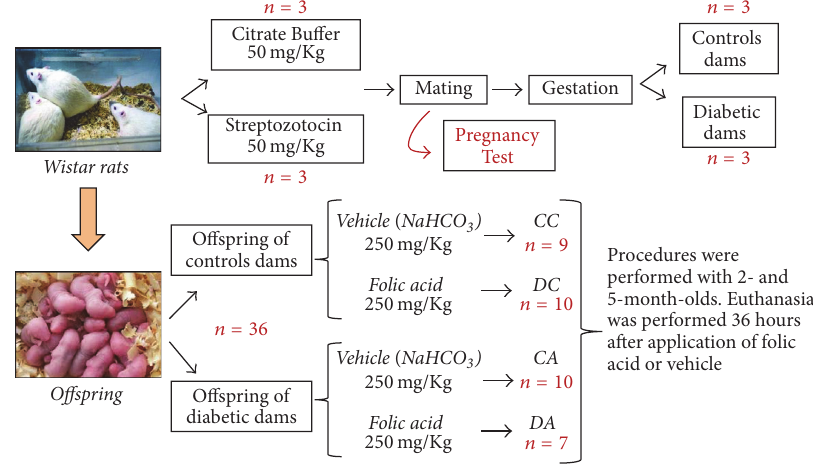
Figure 1: Steps of the